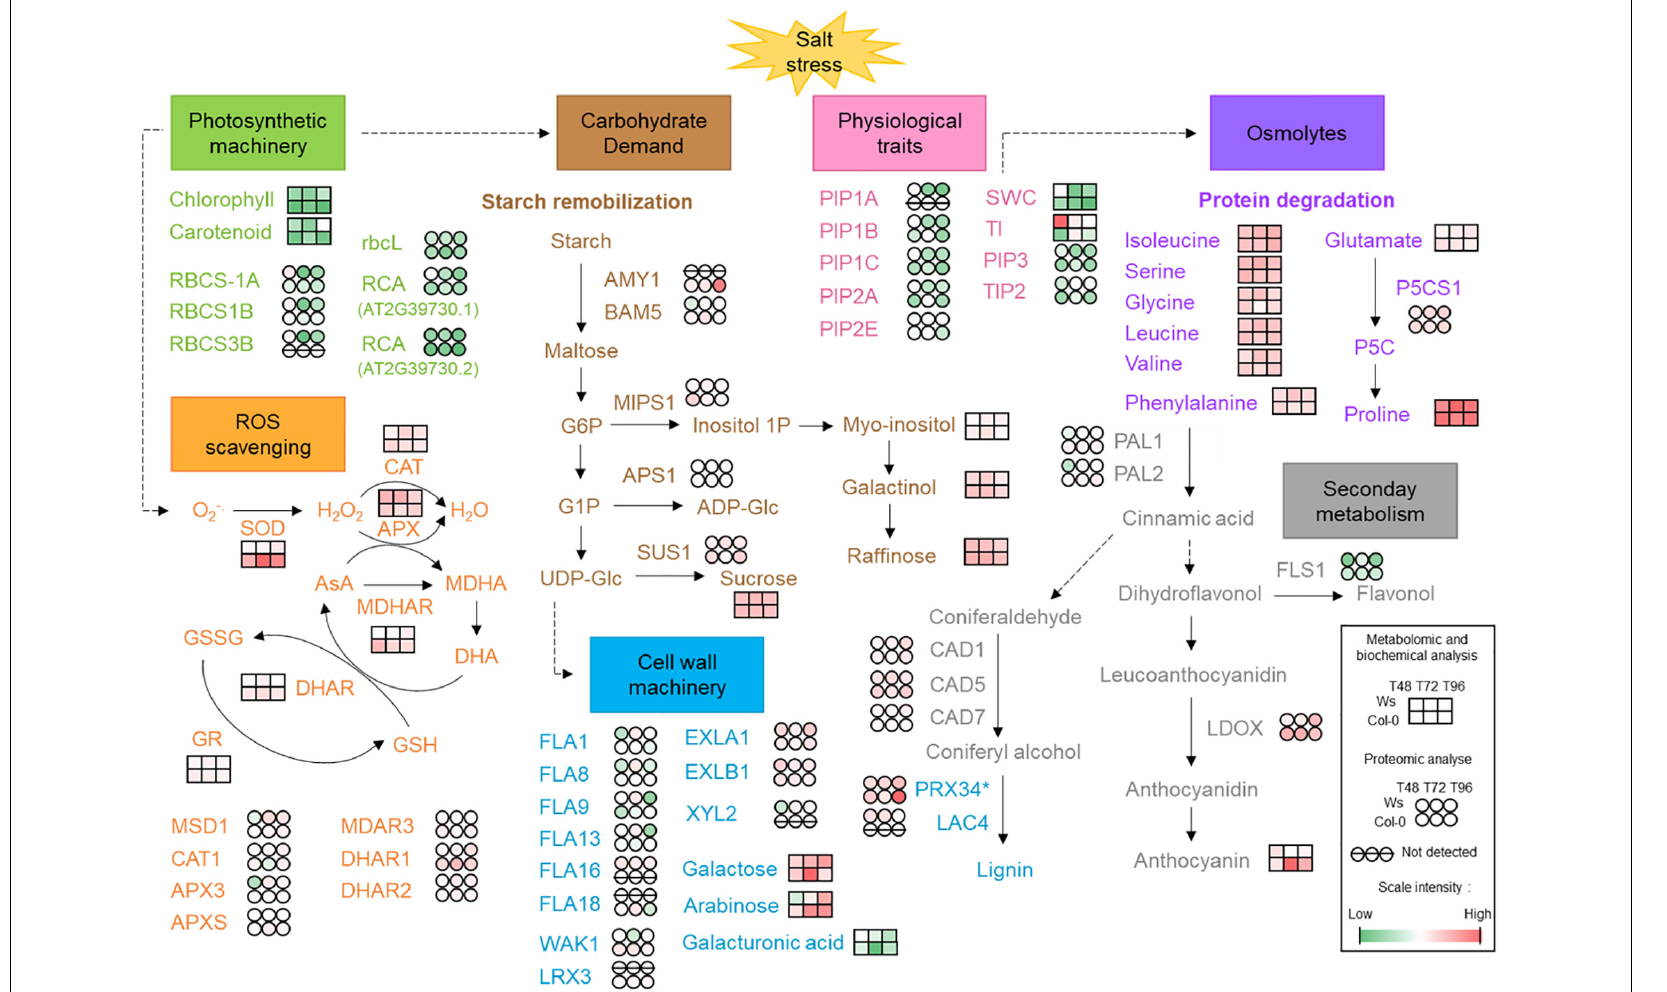
FIGURE 7 | Physiological, biochemical, and molecular aspects identified in response to salt stress in two Arabidopsis ecotypes Ws and Col-0. AMY1, α -amylase 1; APS1, glucose-1-phosphate adenylyltransferase small subunit 1; APX, ascorbate peroxidase; AsA, ascorbic acid; BAM5, β -amylase 5; CAD, cinnamyl alcohol dehydrogenase; CAT, catalase; DHA, dehydroascorbate; DHAR, dehydroascorbate reductase; EXL, expansin-like; FLA, fascilin-like arabinogalactan protein; FLS1, flavonol synthase/flavanone 3-hydroxylase 1; G1P/G6P, glucose 1-phosphate/glucose 6-phosphate; GR, glutathione reductase; GSH; reduced glutathione; GSSG, glutathione-disulfide; Lac, laccase; LDOX, leucoanthocyanidin dioxygenase; LRX, leucine-rich repeat extension protein; MDAR3, monodehydroascorbate reductase 3; MDHA, monodehydroascorbate; MDHAR, monodehydroascorbate reductase; MIPS1, myo-inositol 1-phosphate synthase 1; MSD1, manganese superoxide dismutase 1; P5C, 1-pyrroline-5-carboxylate; P5CS1, delta-1-pyrroline-5-carboxylate synthase 1; PAL, phenylalanine ammonia lyase; PIP, plasma membrane intrinsic protein; Prx, cell wall peroxidase; RCA, ribulose bisphosphate carboxylase/oxygenase activase; rbcL, ribulose bisphosphate carboxylase large chain; RBCS, ribulose bisphosphate carboxylase small chain; ROS, reactive oxygen species; SOD, superoxide dismutase; SUS1, sucrose synthase 1; TI, shoot tolerance index; TIP, tonoplast intrinsic protein; SWC, shoot water content; UDP-Glc, uridine diphosphate glucose; WAK1, wall-associated kinase 1. *Prx34 may be involved in either lignin biosynthesis or ROS detoxification. In red, increased level/activity; in green, decreased level/activity; in white, steady-state